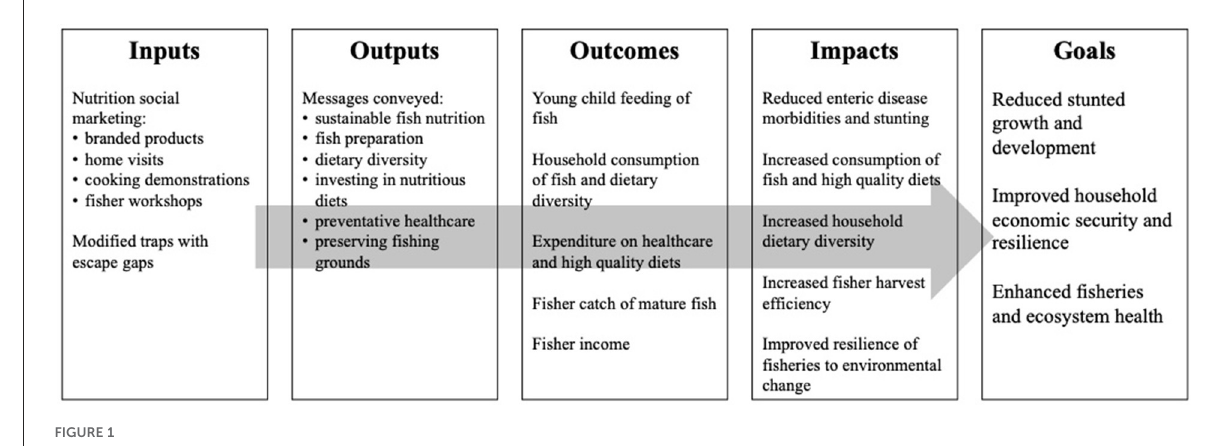
FIGURE1 Logical framework.